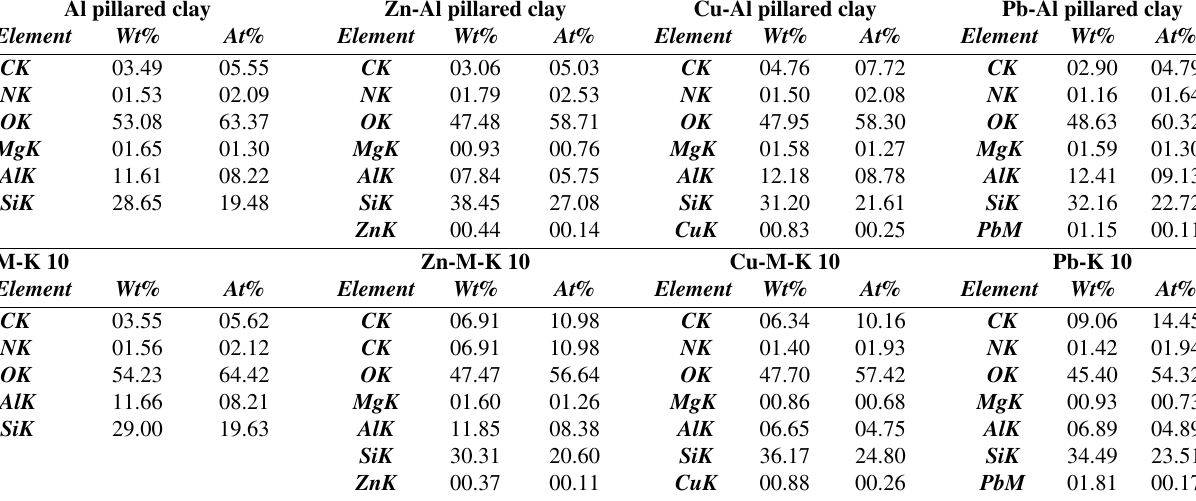
Table 7. Example of elemental composition (weight and atomic %) for each type of studied material for a 65 seconds collection time (20kV). Al pillared clay